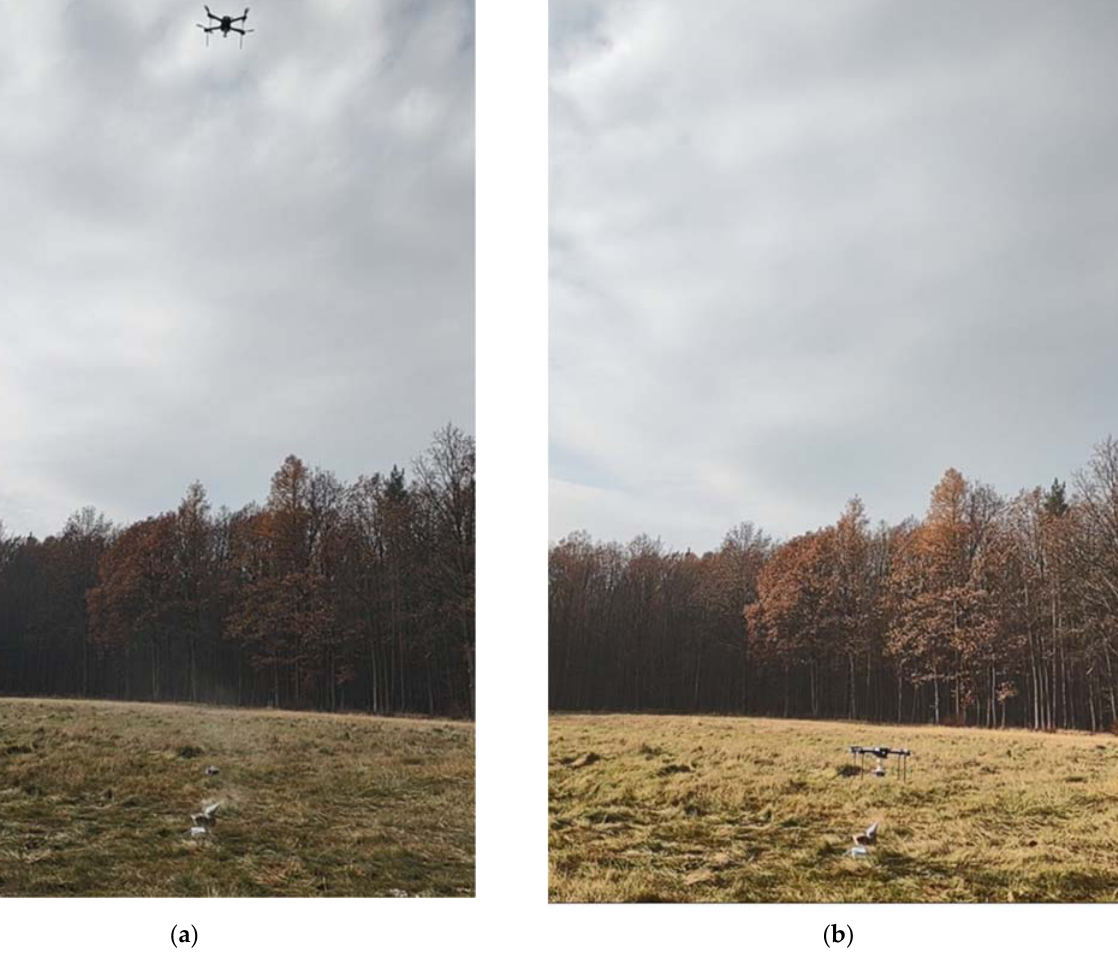
Figure 12. Comparative experiment CE2 (touchwood burning). The sensing platform was: ( a ) low- ered from the drone, ( b ) docked under the drone.